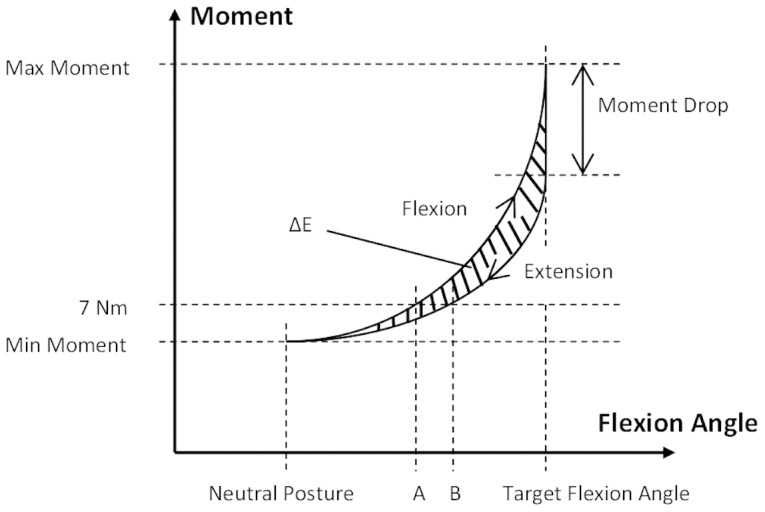
Illustration of a hysteresis loop.The highlighted area (ΔE) denotes the dissipated energy; NZ in flexion (extension) is the distance between point A (point B) and the neutral posture. Target lumbar flexion angle = 30, 40, 60, 80, or 100% FR.